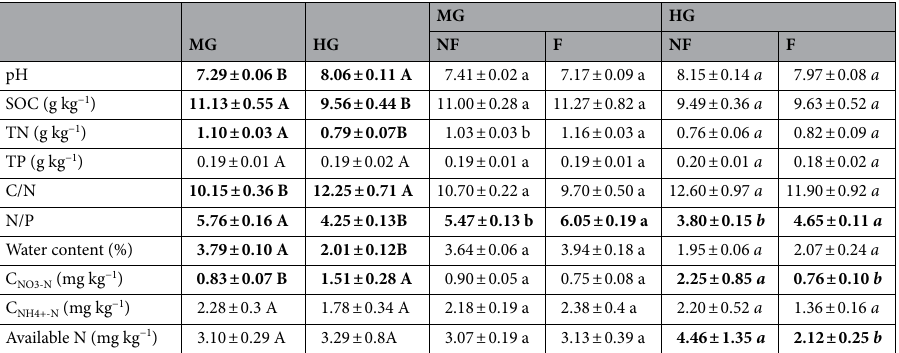
Table 1. Soil physicochemical properties of experimental site with moderately grazed history (MG) and site with heavily grazed management (HG). To compare the effects of heavy grazing and moderate grazing on soil physical and chemical properties with or without enclosure condition, the average values of NF and F under MG/HG condition were calculated and showed in the first two columns of “MG”/“HG”. NF, non-fenced; F, fenced treatment. Different normal and italic lowercase letters indicate differences between non-fenced (free grazing) and fenced treatment at the MG and HG sites, respectively ( p < 0.05, n = 4). Different capital letters indicate differences between the MG and HG sites across non-fenced and fenced treatment ( p < 0.05, n = 8). TN total N concentration, TP total phosphorus concentration, SOC soil organic carbon concentration, C NO3-N NO 3 − -N concentration, C NH4+-N NH 4 + -N